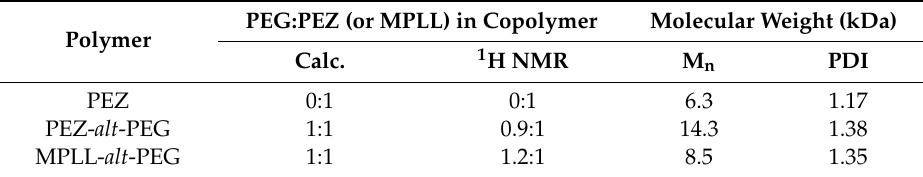
Figure 2. 1 H NMR spectrum of PEZ in DMSO- d 6 ( A ), PEZ- alt -PEG in DMSO- d 6 ( B ), and MPLL- alt -PEG in D 2 O ( C ). Table 1. Compositions and molecular weights of various copolymers.